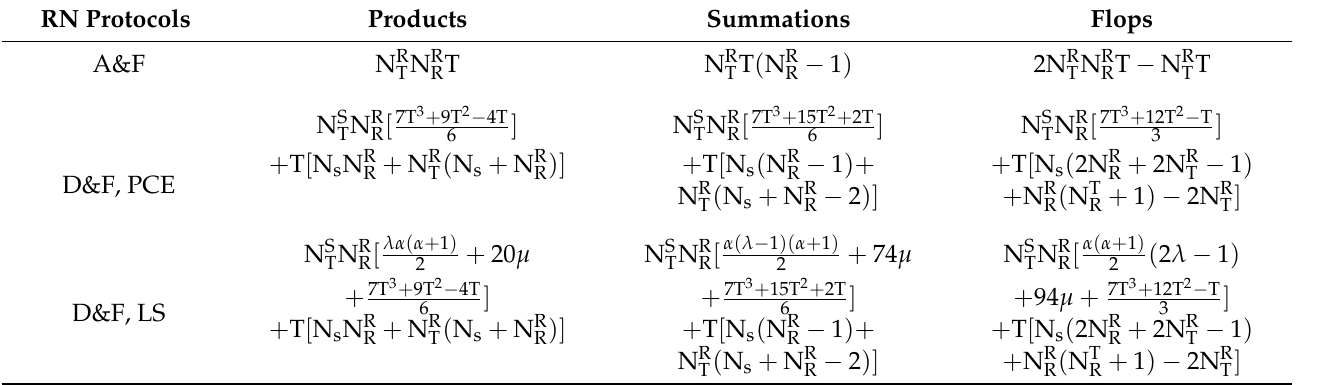
Table 4. Arithmetic operations required by proposed relay node